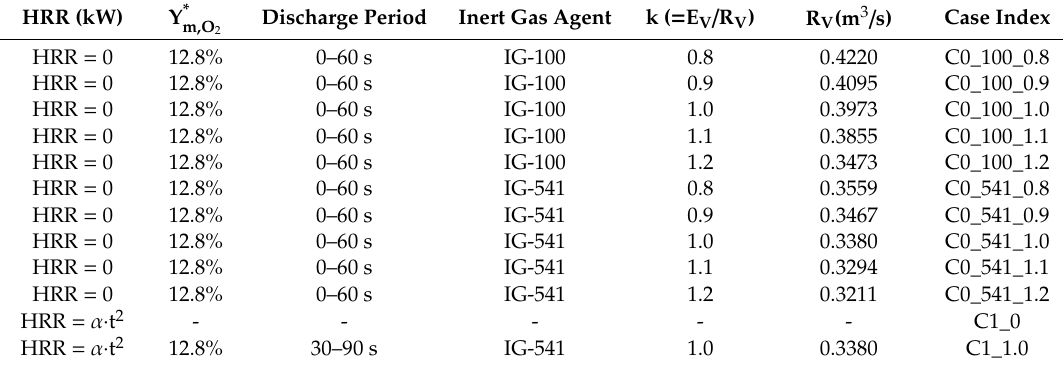
Table 2. Summary of simulation cases. α = 0.0264 s − 2 and “-” represents no parameters are required to set